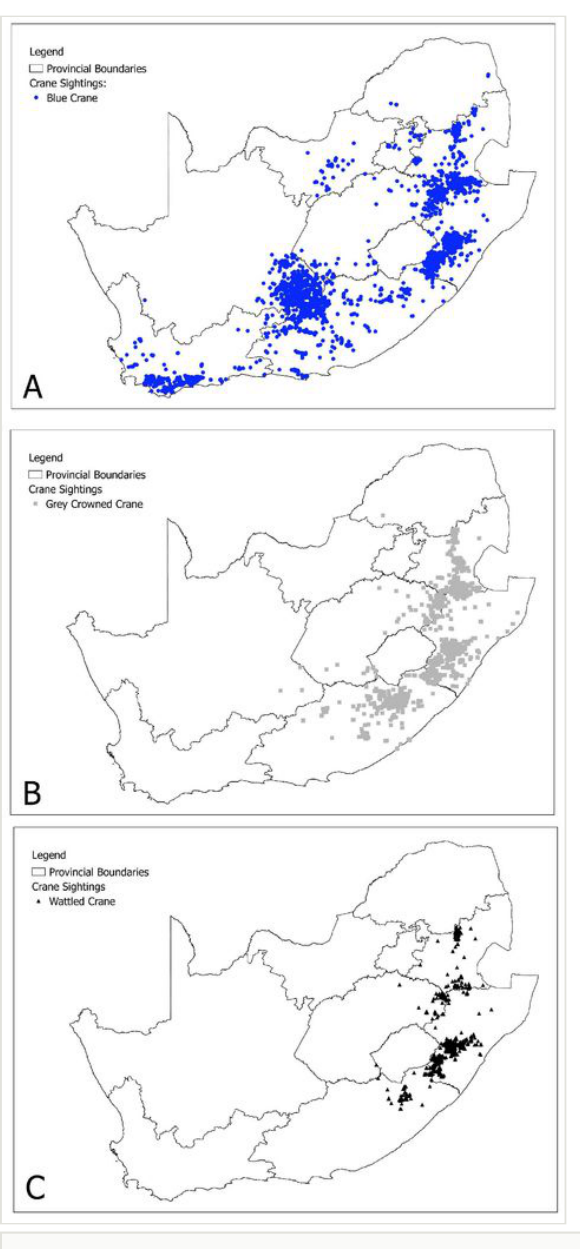
Figure 2. Sightings of three crane species in nine provinces in South Africa (1978-2014). A. Blue Crane. B. Grey Crowned Crane C. Wattled